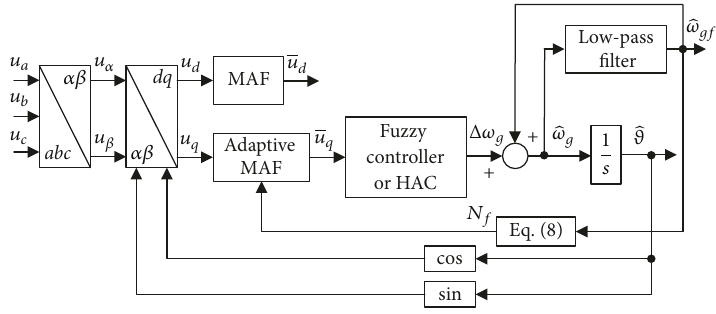
Figure 4: PLL for rapid changes in grid frequency with the fuzzy controller or the HAC and the adaptive MAF.